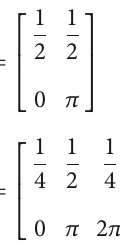
0.6 m/s, respectively. The minimum length of the hoisting cable is set to 2 m while the maximum length is set to 10